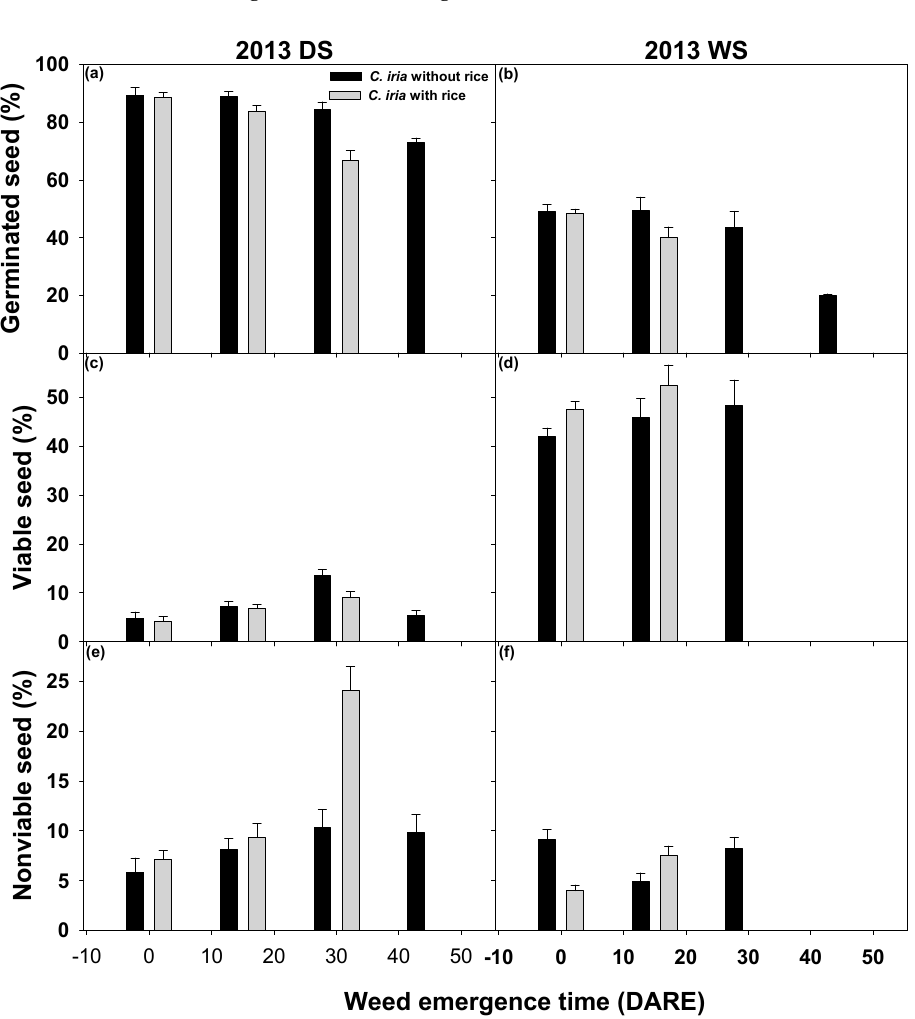
Figure 7. Effect of emergence time of weed in the dry (DS) and wet seasons (WS) of 2013 on C. iria per-plant seed germination ( a , b ), viability ( c , d ), and nonviability ( e , f ). Black bars show data for C. iria plants grown alone without rice plants (Rice 0), and grey bars show data for C. iria plants grown with rice at a seed rate of 50 kg ha − 1 (Rice 50). The standard error of the means is represented by vertical bars.